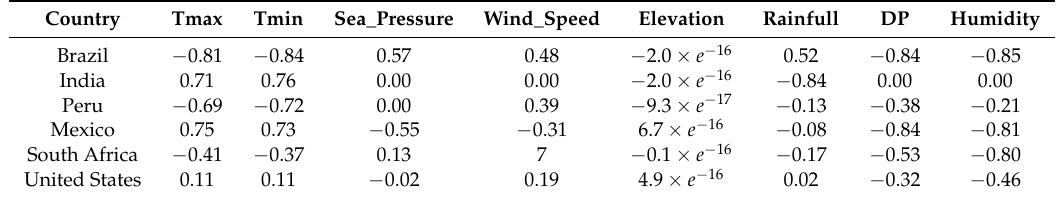
Table 5. Correlation Coefficient between New and Climate Variables in the Top Six Countries. Country Tmax Tmin Sea_Pressure Wind_Speed Elevation Rainfull DP Humidity Brazil − 0.81 − 0.84 0.57 0.48 − 2.0 × e − 16 0.52 − 0.84 − 0.85 India 0.71 0.76 0.00 0.00 − 2.0 × e − 16 − 0.84 0.00 0.00 Peru − 0.69 − 0.72 0.00 0.39 − 9.3 × e − 17 − 0.13 − 0.38 − 0.21 Mexico 0.75 0.73 − 0.55 − 0.31 6.7 × e − 16 − 0.08 − 0.84 − 0.81 South Africa − 0.41 − 0.37 0.13 7 − 0.1 × e − 16 − 0.17 − 0.53 − 0.80 United States 0.11 0.11 − 0.02 0.19 4.9 × e − 16 0.02 − 0.32 −